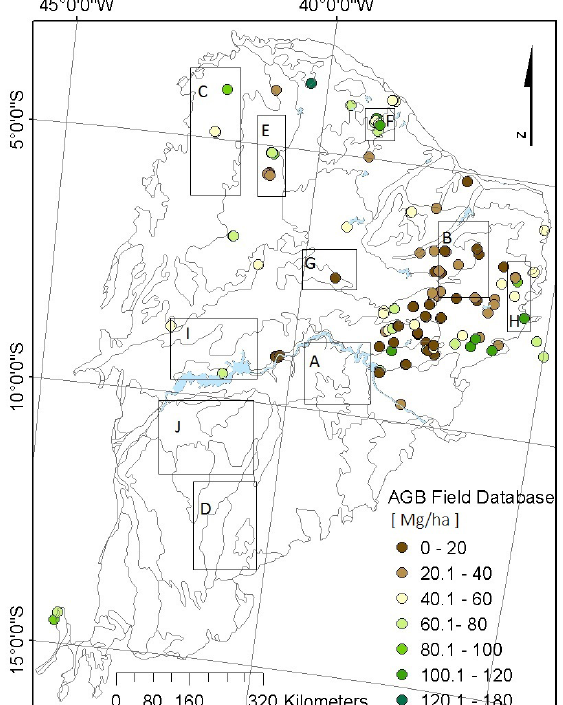
Figure 3. 30 m spatial resolution satellite estimated above ground biomass (Zarin et al. 2016). The insert boxes (from A to J) are for reference to specific regions highlighted in the discussion